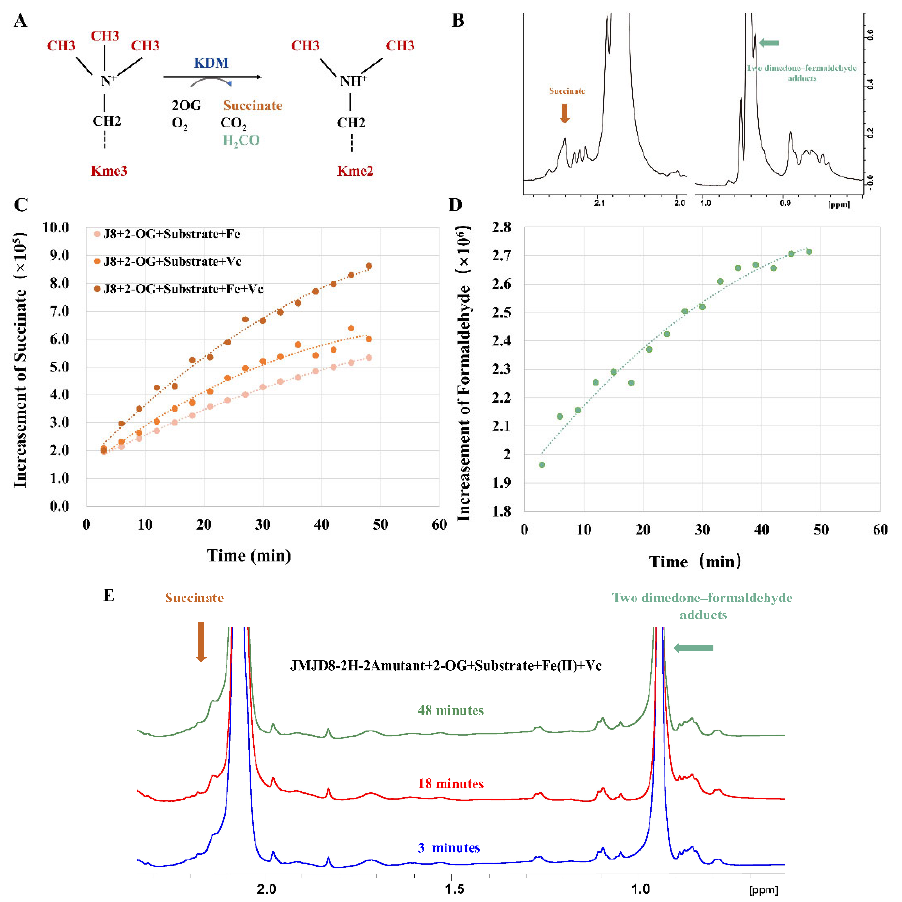
Figure 2. NMR analysis of demethylase activity. ( A ) Oxygen- and 2OG-dependent catalytic activities displayed by JMJD proteins toward tri-methylated lysine residue with coproduct succinate, carbon dioxide and formaldehyde. ( B ) 1 H NMR spectrum of the JMJD8-catalysed demethylation of AKT-K140A-K142me3. ( C ) Graphs showing the degree of succinate production catalyzed by JMJD8 as quantified by 1 H NMR (600 MHz). ( D ) Detection of an increment of formaldehyde release during JMJD8-catalysed trimethylated lysine demethylation. Dimedone reacts with formaldehyde in aqueous solution to form stable adducts that are detectable using 1 H NMR. Incubation of a reaction mixture containing JMJD8 (6.7 µ M), AKT1-K142me3 peptide (250 µ M), 2OG (0.2 mM), ascorbate (0.5 mM), iron (II) (0.1 mM) and dimedone (1 mM) revealed the formation of two dimedone adducts using 1 H NMR (600 MHz). ( E ) Time-dependent 1 H NMR spectrum showing that no detectable succinate or formaldehyde was generated during the demethylation of AKT-K140A-K142me3 mediated by